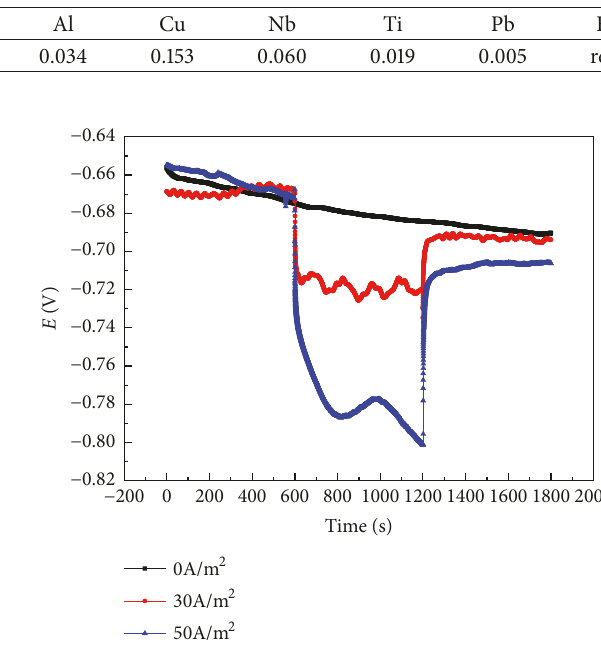
Table 2: The chemical composition of X80 pipeline steel (quality)%.